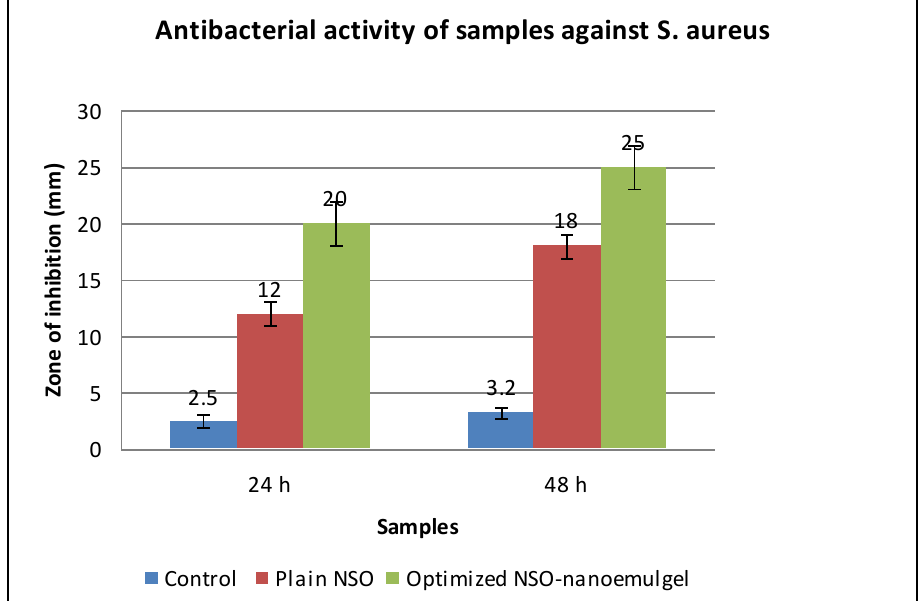
Figure 8. Antibacterial activity of control, plain NSO, and NSO-nanoemulgel formulation against S. aureus as the test microorganism (n = 3).